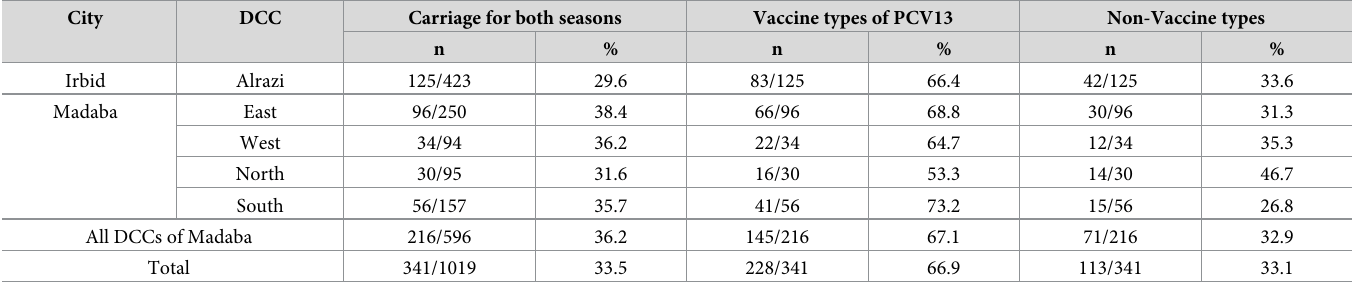
Table 3. Rate of carriage of Streptococcus pneumoniae from Irbid and Madaba DCCs for both winter seasons of W2017-18 and W2018-19 with vaccine types and non-vaccine types.